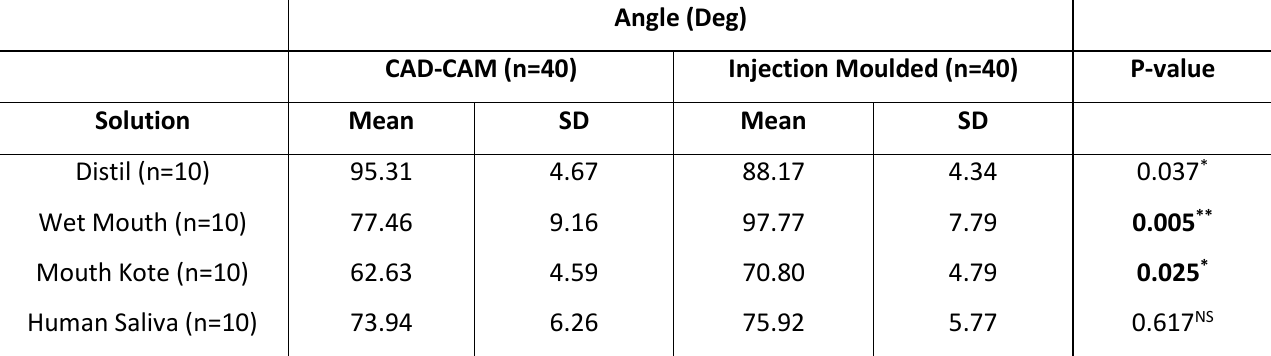
Table 1. Inter-material group comparison (CAD-CAM vs injection moulded) of mean angular measurement according to type of solution.